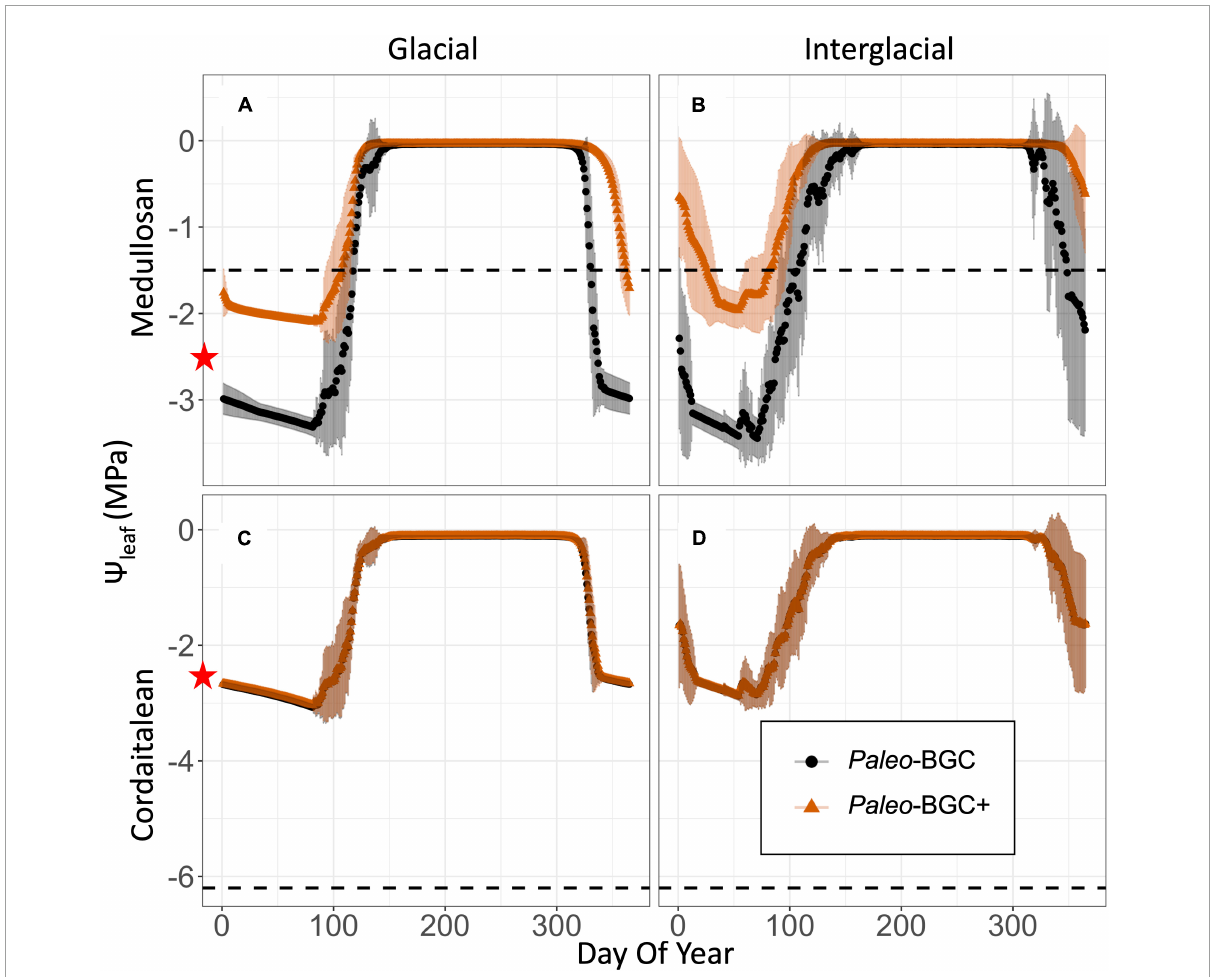
FIGURE5 Water potentials in Paleo -BGC and Paleo -BGC + simulations as they relate to sapwood limitation of stomatal conductance. Intra-annual leaf water potentials ( (cid:57) leaf , A–D ), are shown for both the original model implementation ( Paleo -BGC, black) and Paleo -BGC with sapwood limitations ( Paleo -BGC+, orange) along with the mean cavitation pressure ( ¯ (cid:57) c , dotted line in A–D ) of each plant type. At (cid:57) leaf below the dotted line 50% of sapwood conductivity is lost to cavitation. Vulnerable plant types like medullosans (A,B) spent much of the year with 50% or more loss sapwood of conductivity, while resistant types like cordaitaleans (C,D) were unaffected by sapwood dysfunction. Symbols are at daily means annualized for 50 years of simulation, and shading represents one standard deviation from the mean of 50 years of simulation. The red star on the vertical axes is placed at the prescribed leaf wilting water potential (–2.5 MPa, White et al., 2020). In vulnerable taxa (e.g., medullosan, A,B ) simulated sapwood dysfunction stopped stomatal conductance before leaf